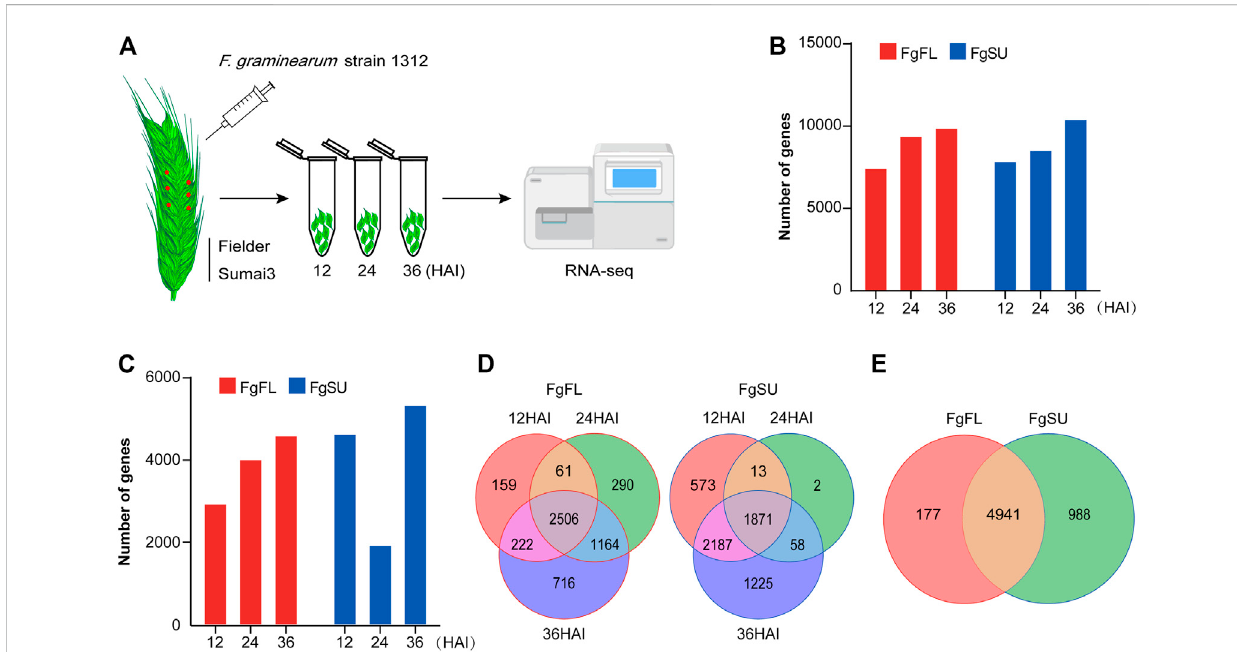
FIGURE 1 Inoculation procedure and transcriptomics of Fusarium graminearum in planta . (A) Schematic work fl ow of Fusarium graminearum transcriptomic analysis in planta . Brie fl y, the FHB-susceptible wheat variety Fielder and FHB-resistant wheat variety Sumai3 were cultivated to midanthesis under standard conditions. Then, six spikelets on three spikes of each variety were point-inoculated using Fusarium graminearum strain Fg1312 inoculum or water(Mock).At12,24,and36HAI,theseinoculatedmaterialswereharvestedseparatelyandusedforRNA-Seq.ThereadsgeneratedbyRNA-Seq in planta were then mapped to the Fusarium graminearum genome. (B) Number of genes mapped to the Fusarium graminearum PH-1 genome. (C) Number of in planta -expressed genes identi fi ed at three timepoints after inoculation. Log2 (foldchange) ≥ 1 and P adj < 0.05 between Fusarium graminearum -inoculated samples and mock-inoculated samples were used as the criteria to identify Fusarium graminearum genes expressed in planta , which caneliminatetheinterferenceofthewheatgenome. (D) Dynamicdistributionofgenesexpressedinthedifferentvarieties. (E) Venndiagrams ofall genes expressed in the different varieties. Most genes (~81%) were expressed in both varieties, while a few genes were speci fi cally expressed in Fielder (~3%) or Sumai3 (~16%). FgFL, F. graminearum genes expressed in Fielder; FgSU, F. graminearum genes expressed in